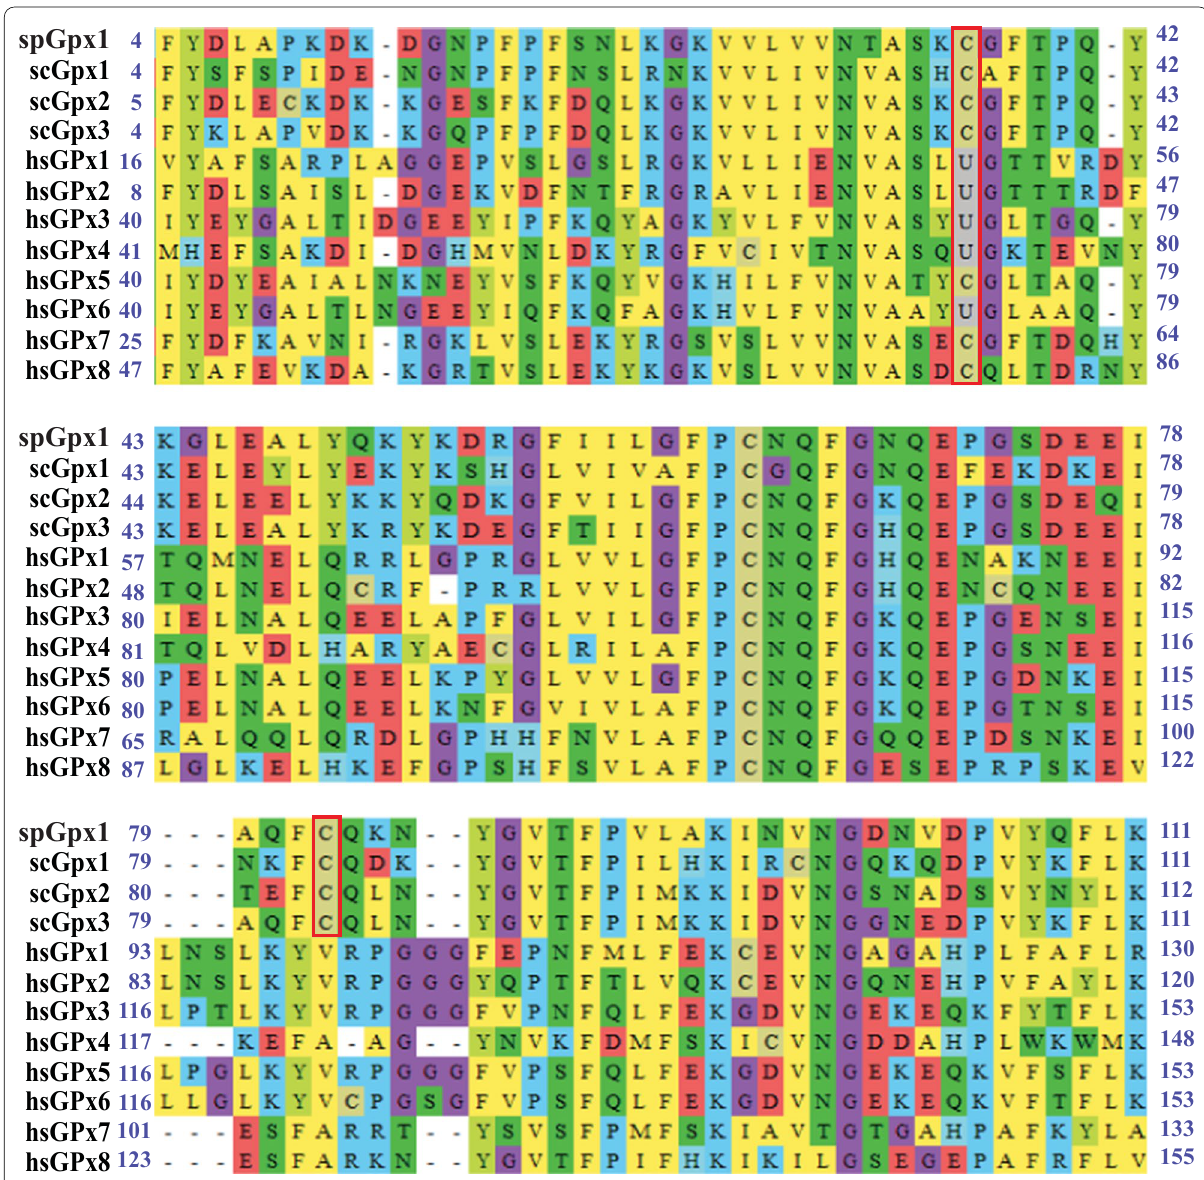
Fig. 1 Multiple sequence alignment of sequences of the GSHPx domain in S. pombe , S. cerevisiae and human GPxs using the MEGA_X_10.1.8 software. The GSHPx domain was identified by searching the SMART database. The two characteristic residues (one Cys/Sec residue and one Cys residue) are boxed. Amino acid residues are highlighted according to the biochemical properties of the amino acid